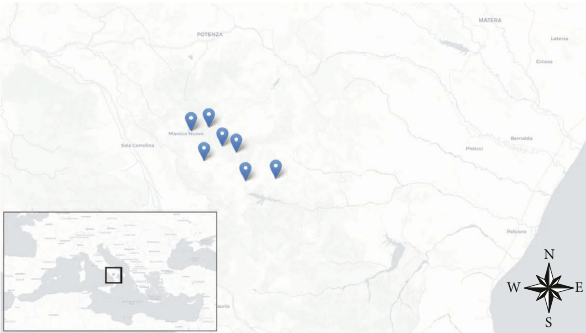
Figure 1: The application case study is in the Val d’Agri, Basilicata, Southern Italy. The blue placemarks identify the seven operational weather stations specifically installed in the region. Over six of them, a benchmark analysis for short-term temperature forecasts has been carried